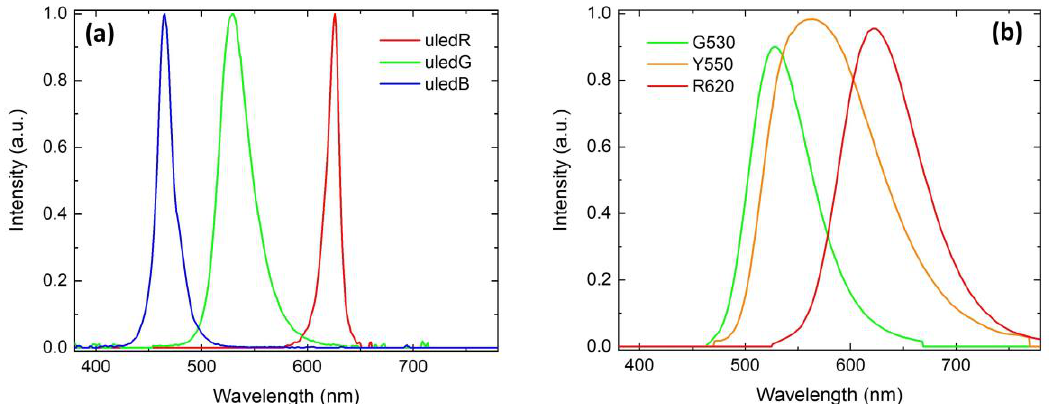
Figure 3. ( a ) Measured RGB (red, green, and blue) micro-LED spectra from PlayNitride [25]. ( b ) Spectra of some commercial phosphors.